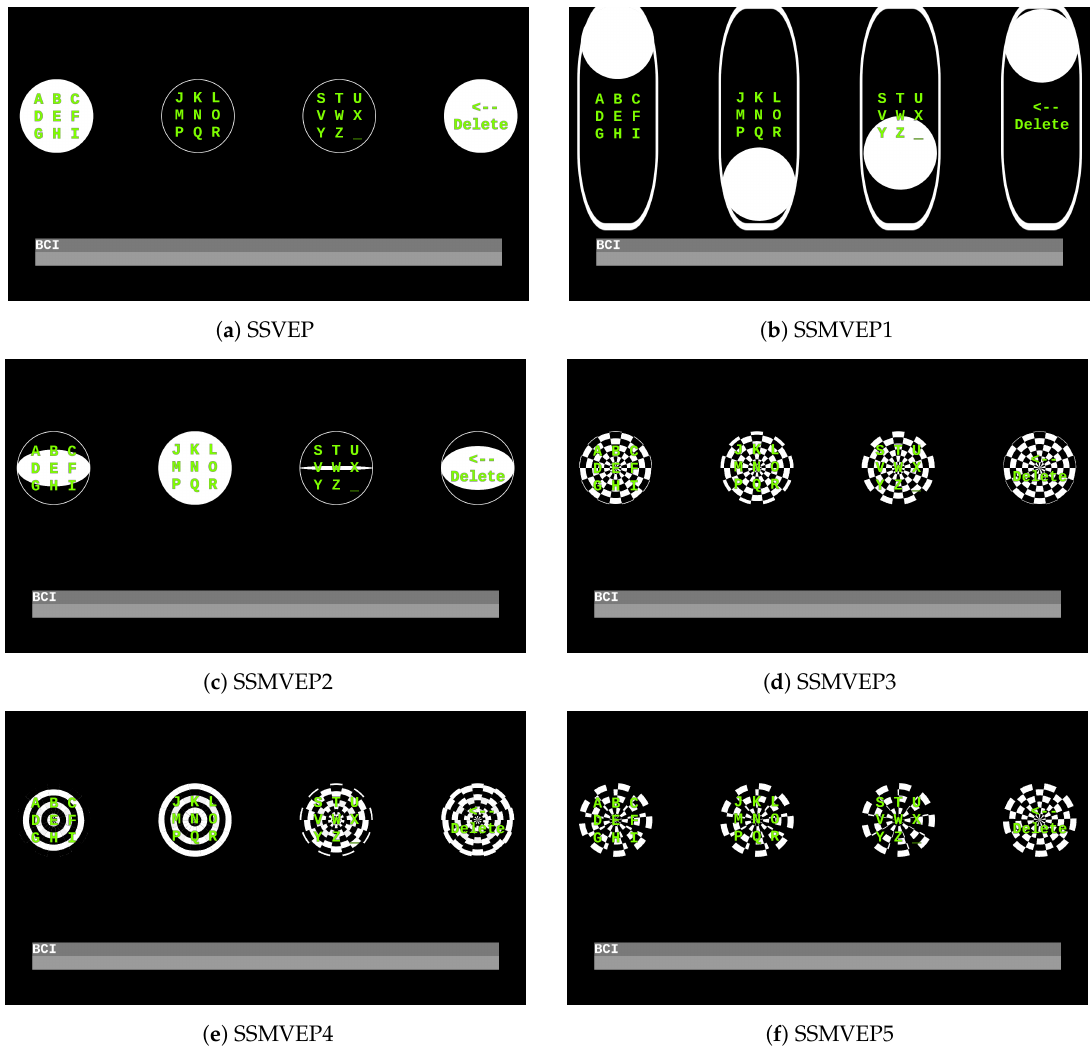
Figure 2. Different versions of flicker-free SSMVEP stimulus (working example) patterns evaluated in this study, presented during the stimulation in different phases. ( a ) Standard steady-state visual evoked potentials (SSVEP) stimulation during the stimulation. The middle boxes are in the off state and the outer boxes are in the on state. ( b ) The SSMVEP1 stimulation (pendulum behavior). The stimulation circle moves above and below it’s starting, central position. ( c ) The SSMVEP2 stimulation (flipping-coin behavior). The stimuli changes it’s vertical size during the stimulation. This motion pattern creates the illusion of a coin that rotates horizontally around its vertical axis. ( d ) The SSMVEP3 stimulation (pulsation behavior). The stimuli was composed of six layers of 20 degree black and circular sectors composed into a checkerboard. The motion consisted of contractions and expansions while keeping a constant ratio. ( e ) The SSMVEP4 stimulation (reverse (inverse) arcs pulsation behavior behavior). In this stimuli design each checkerboard group of arcs (20 degrees sector) moved in opposite directions (inwards and outwards) to its neighbor. ( f ) The SSMVEP5 stimulation (reverse (inverse) arcs rotation behavior). Here the 20 degree checkerboard arcs rotated 20 degrees in opposite